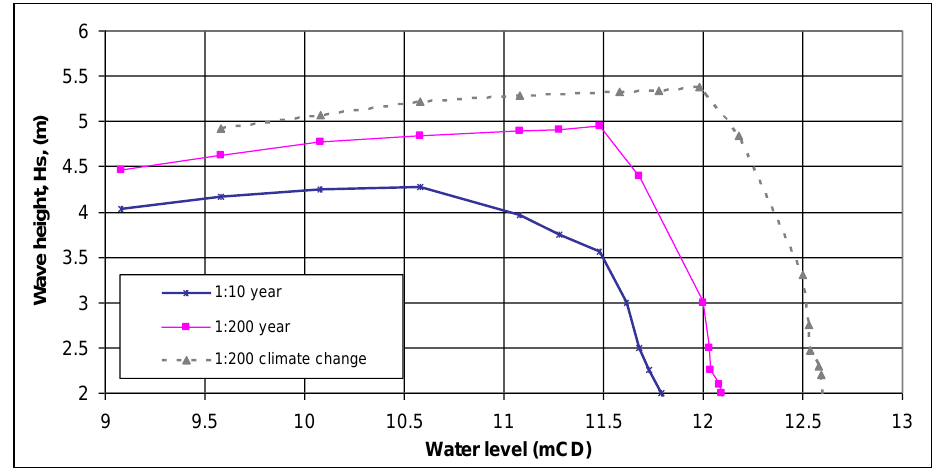
Figure 11. Initial JPA conditions for Position C.